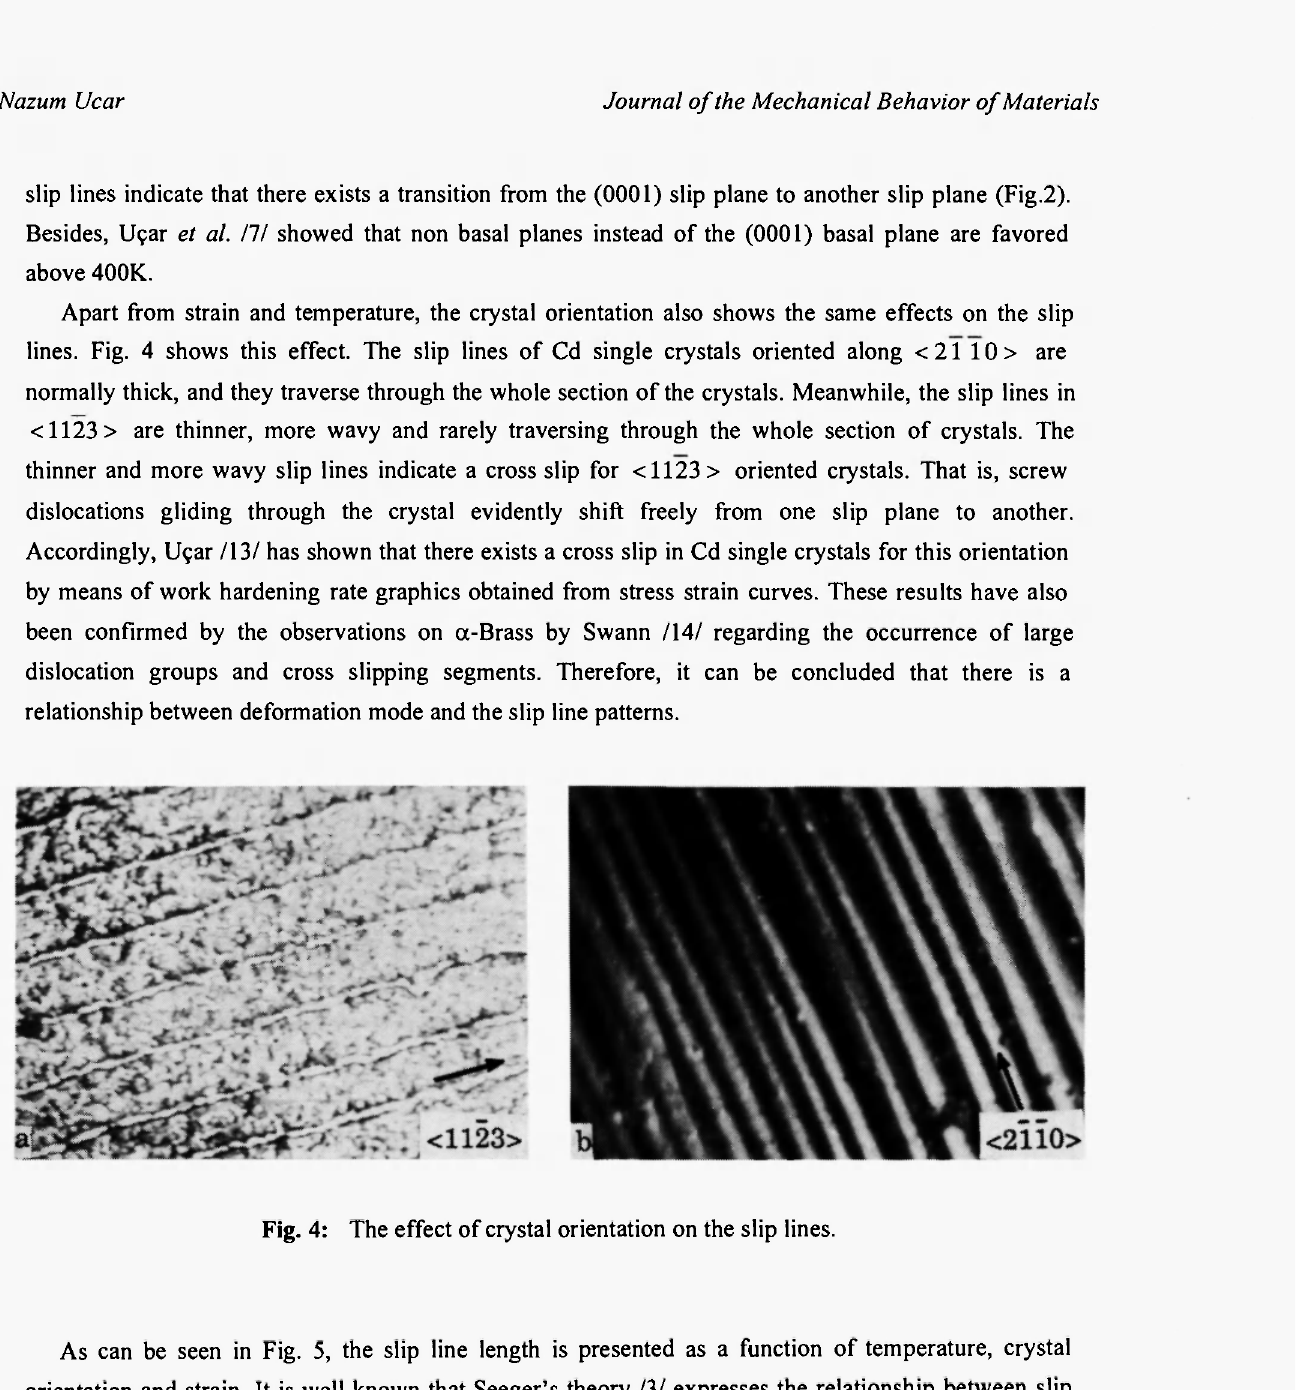
Fig. 4: The effect of crystal orientation on the slip